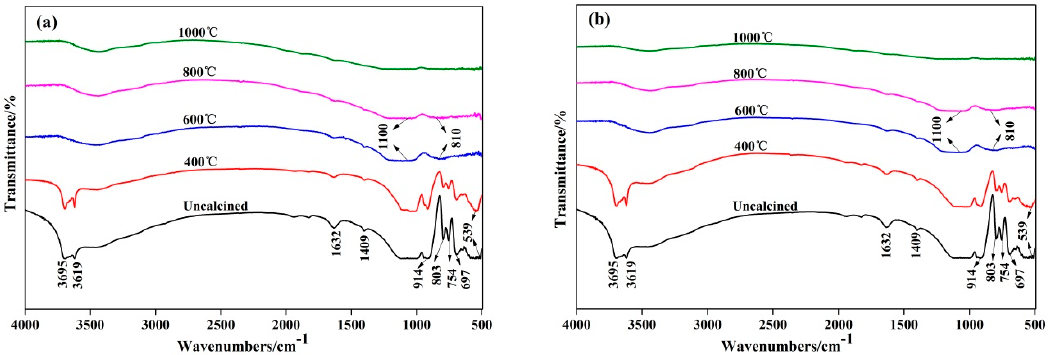
Figure 9. Fourier transform infrared spectroscopy spectra of calcined products by fluidized calcination ( a ) and static calcination ( b ) at different temperatures.